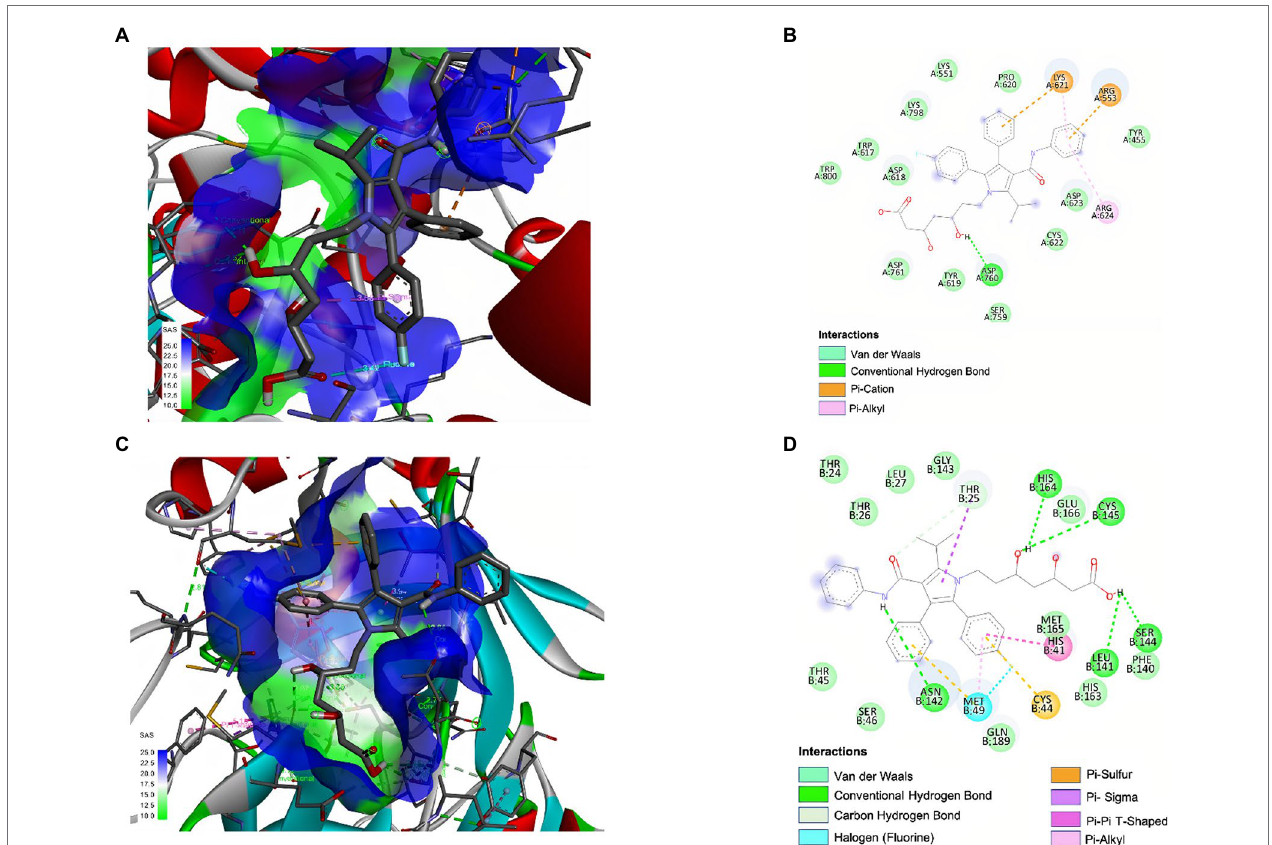
FIGURE 7 | Interaction of ATV with SARS-CoV-2 RdRp and 3CL protease by molecular docking. 3D and 2D representations of the main interaction of ATV and two SARS-CoV-2 proteins by molecular docking. The images represent ATV interaction with: RdRp (PDB:6 M71) depicted in 3D (A) and 2D (B) , and 3CL protease (PDB: 6M2N) of SARS-CoV-2 depicted in 3D (C) and 2D (D) . The interactions formed in the complexes are described in each figure. The images were obtained using BIOVIA Discovery Studio Visualizer